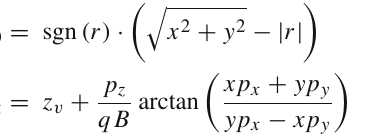
of energy. These couplings are taken real for